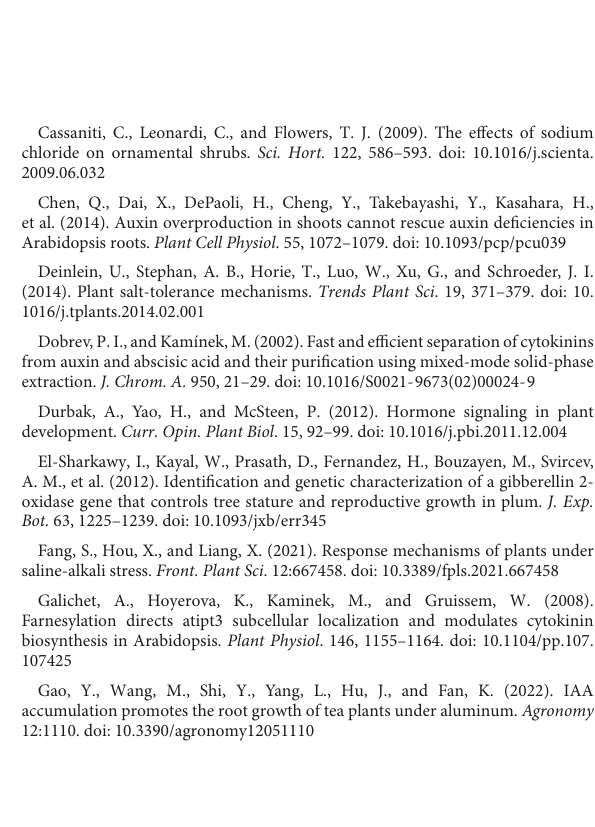
SUPPLEMENTARYFIGURE1 Representative chromatogram of hormone standards and tissue extracts of bermudagrass under salt stress (A) cytokinin standards; (B) cytoinin in tissues; (C) ABA, auxin andGA3 standards; (D) ABA, auxin and GA3 in